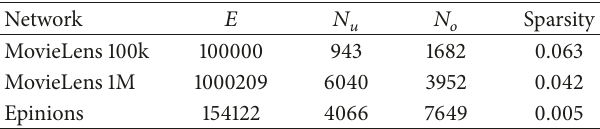
Table 1: Basic properties of the three data sets and the sparsity is defined as 𝐸/(𝑁 𝑢 𝑁 𝑜 ) .